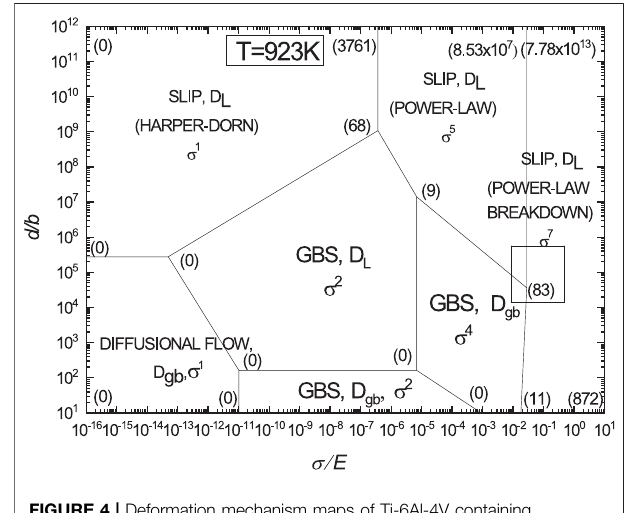
FIGURE 4 | Deformation mechanism maps of Ti-6Al-4V containing dislocation count (T (cid:2) 923 K).